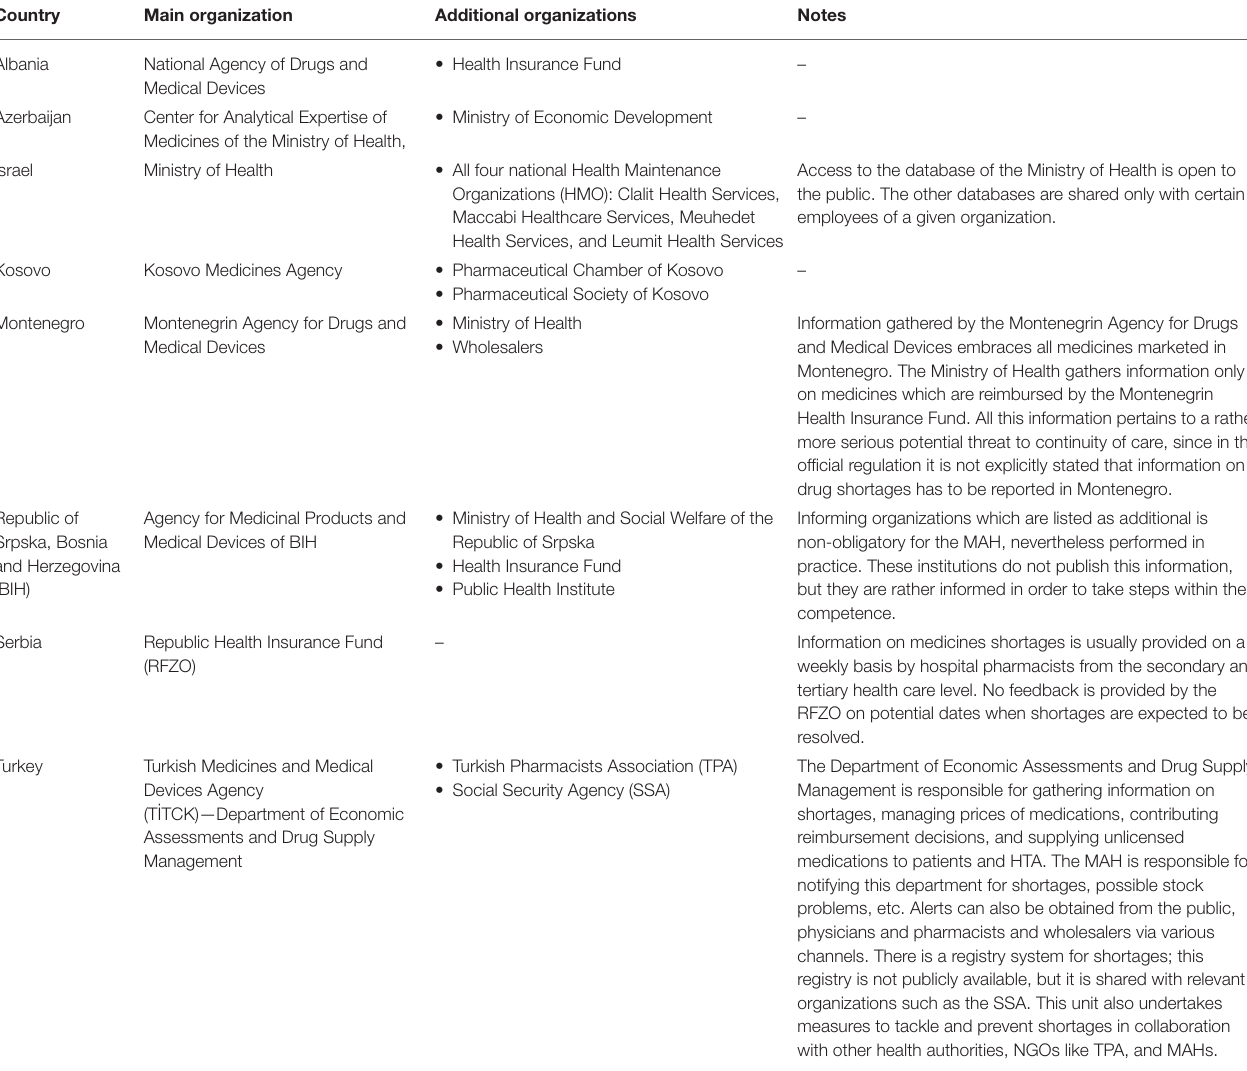
TABLE 4 | Organizations involved in gathering information (“information hubs”) on drug shortages in countries outside of the area of the European Union and European Free Trade